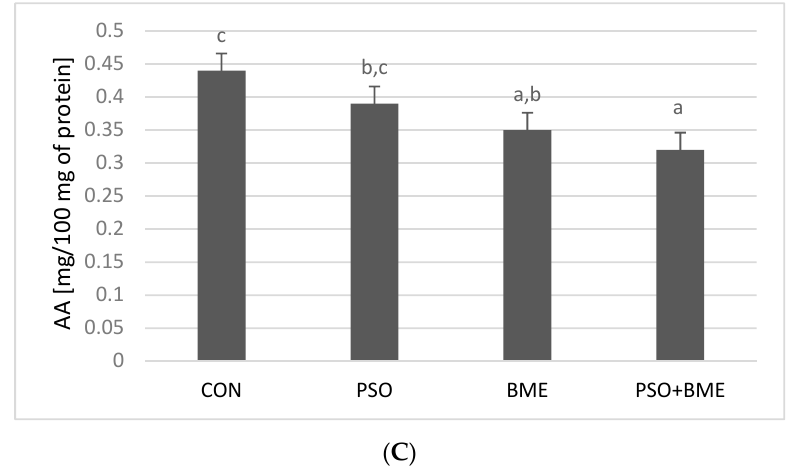
Figure 6. Activities of D6D ( A ) and D5D ( B ) in hepatic microsomes of experimental groups. AA concentration increase (mg / 100 mg protein) in rat hepatic microsomes ( C ). CON—control group; PSO—group receiving PSO in the amount of 0.15 mL / day; BME—group receiving BME ad libitum; PSO + BME—group receiving PSO in the amount of 0.15 mL / day and BME ad libitum. All data are shown as mean values ± standard deviation of data obtained from all animals ( n = 12) in each group. Values with a di ff erent letter index in one row are significantly di ff erent from each other ( p ≤ 0.05) in post-hoc RIR Tukey test or multiple comparison test. D6D— ∆ 6 -desaturase index ( × 10 − 3 ),